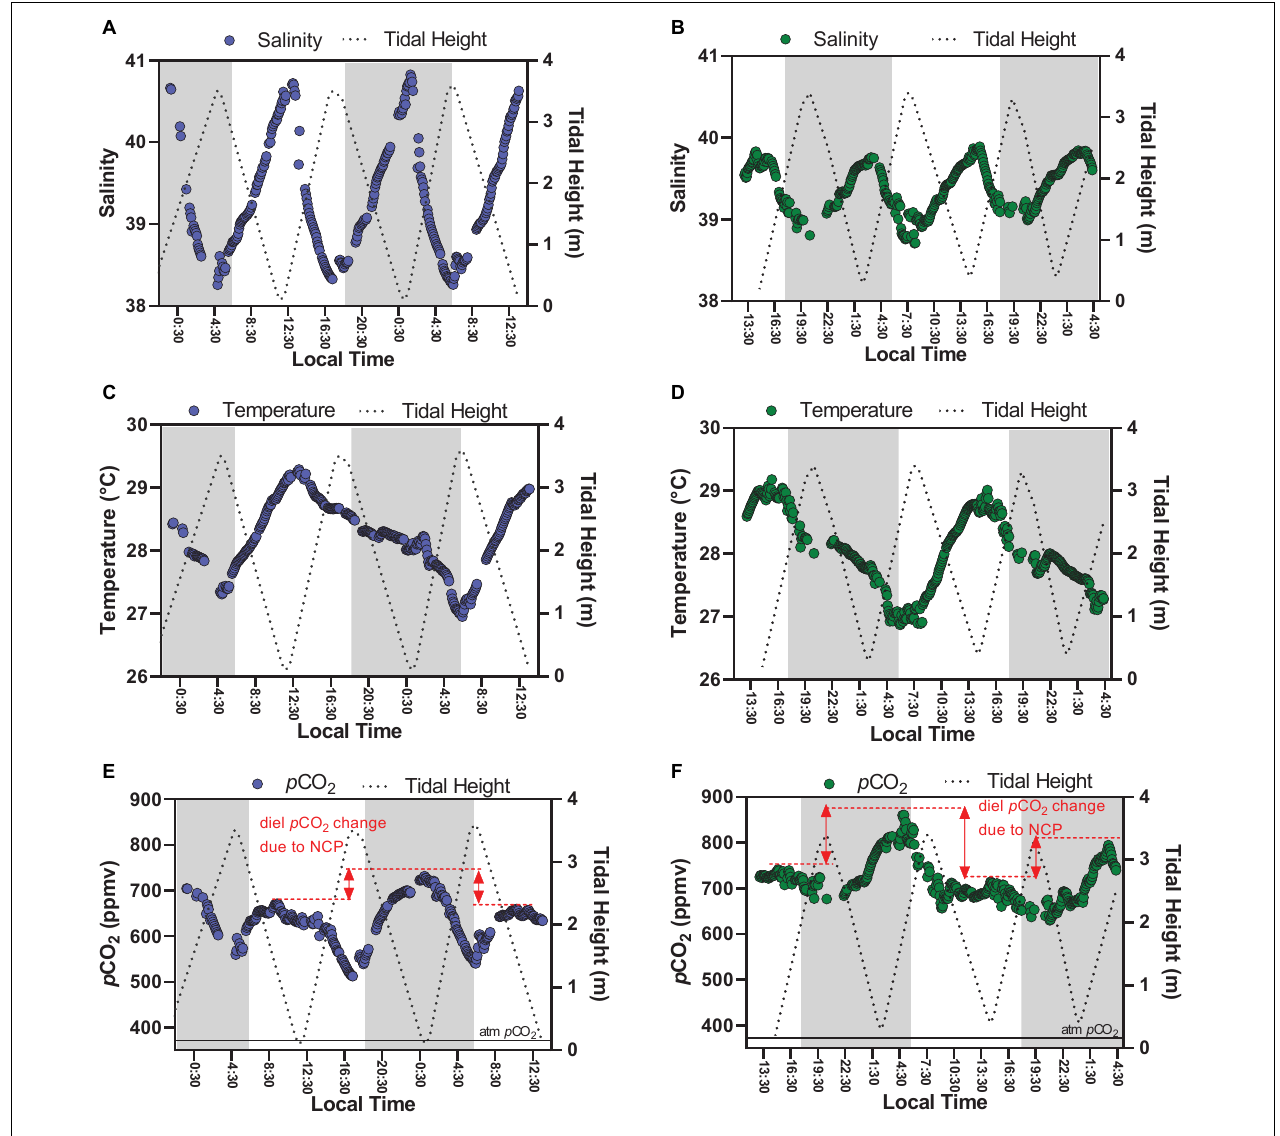
FIGURE 3 | Time-series observations of parameters measured continuously, which are salinity (A,B) , temperature (C,D) , and p CO 2 (E,F) . Graphs on the left side represent Oct-2017 (blue dots); graphs on the right side represent Sep-2018 (green dots). The red lines in graphs (E,F) illustrate the diel variability of p CO 2 values by comparing peaks of low tides occurring at different hours of the day (daytime × night-time).